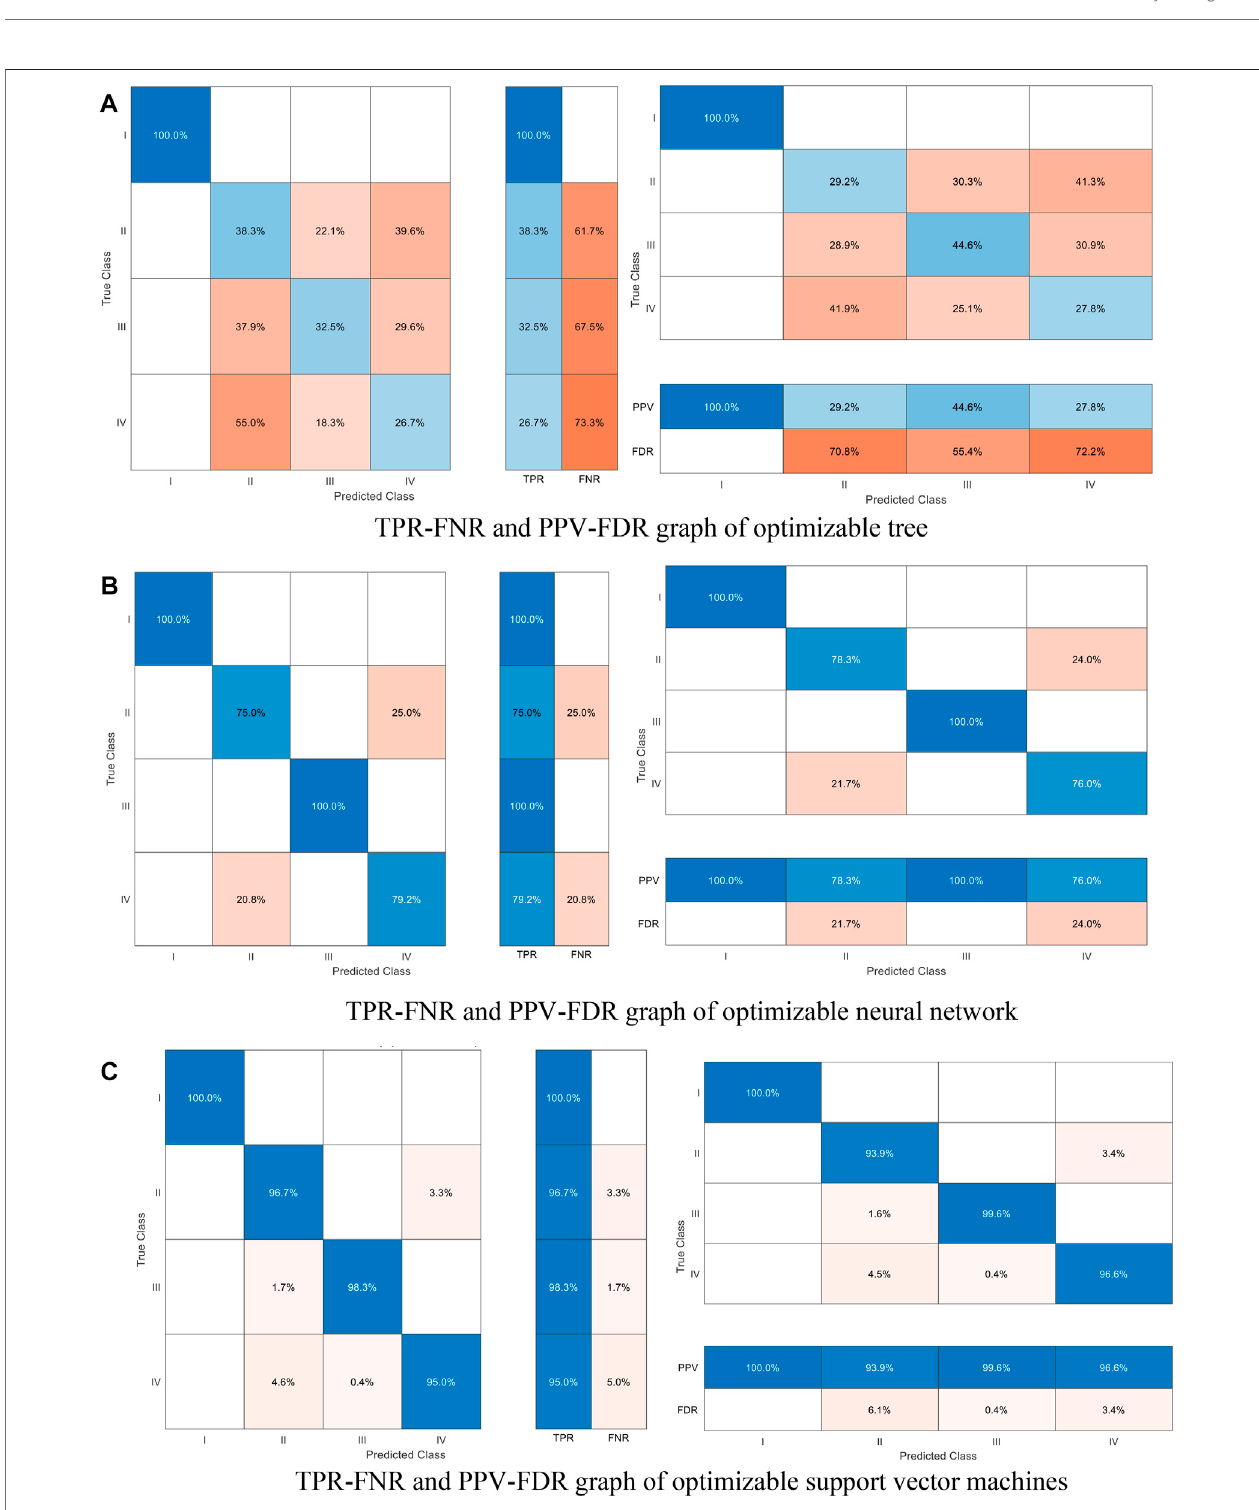
FIGURE8| TPR-FNRandPPV-FDRgraphsofdifferentalgorithmresults. (A) TPR-FNRandPPV-FDRgraphofoptimizabletree, (B) TPR-FNRandPPV-FDRgraph of optimizable neural network and (C) TPR-FNR and PPV-FDR graph of optimizable support vector machines.